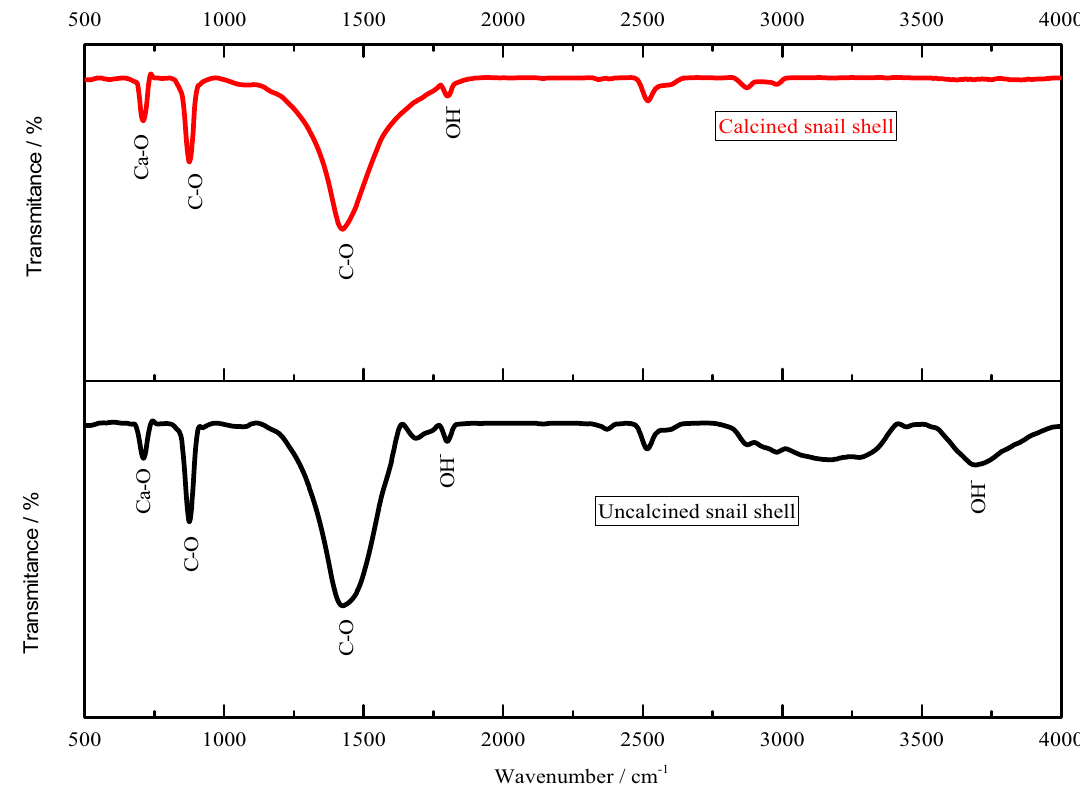
Fig. 4 FT-IR spectral of raw snail shells and calcined snail